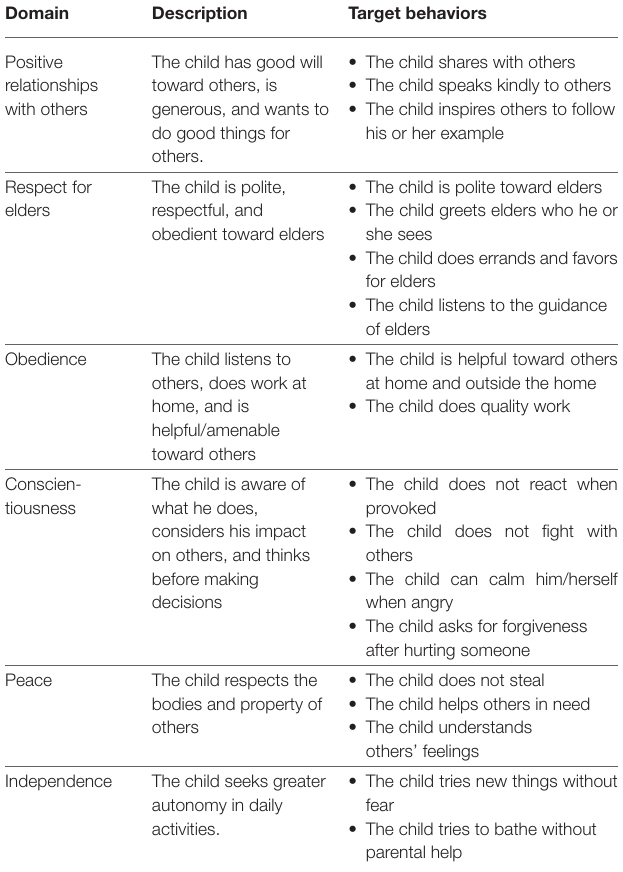
TABLE 5 | Baka SEL framework. Domain